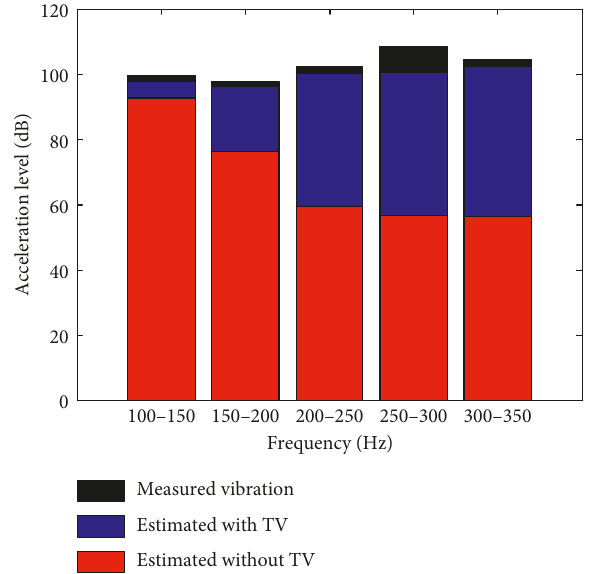
Figure 13: The overall acceleration level between estimated and measured